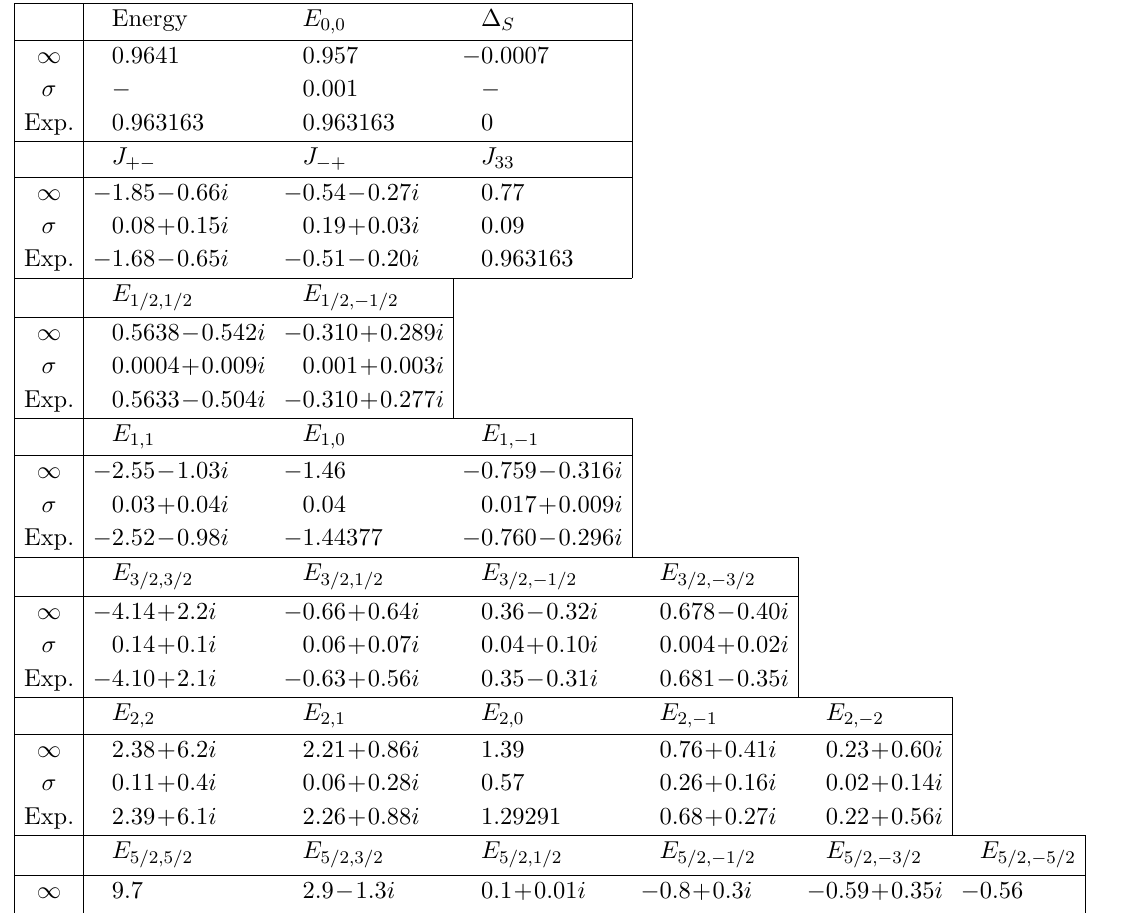
Table 32 . Extrapolations of observables of a solution describing probably an SU(2) 0-brane with ( ρ 0 . 99 ) and SL(2, C ) 0-brane with θ θ 1 = 2 π 1 ≈ k boundary conditions. Extrapolations are done only using even level data due to odd level